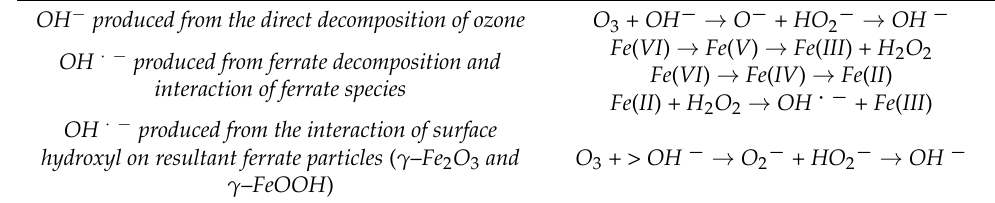
Table 7. The mechanism of forming OH − radicals in the ferrate/ozone system